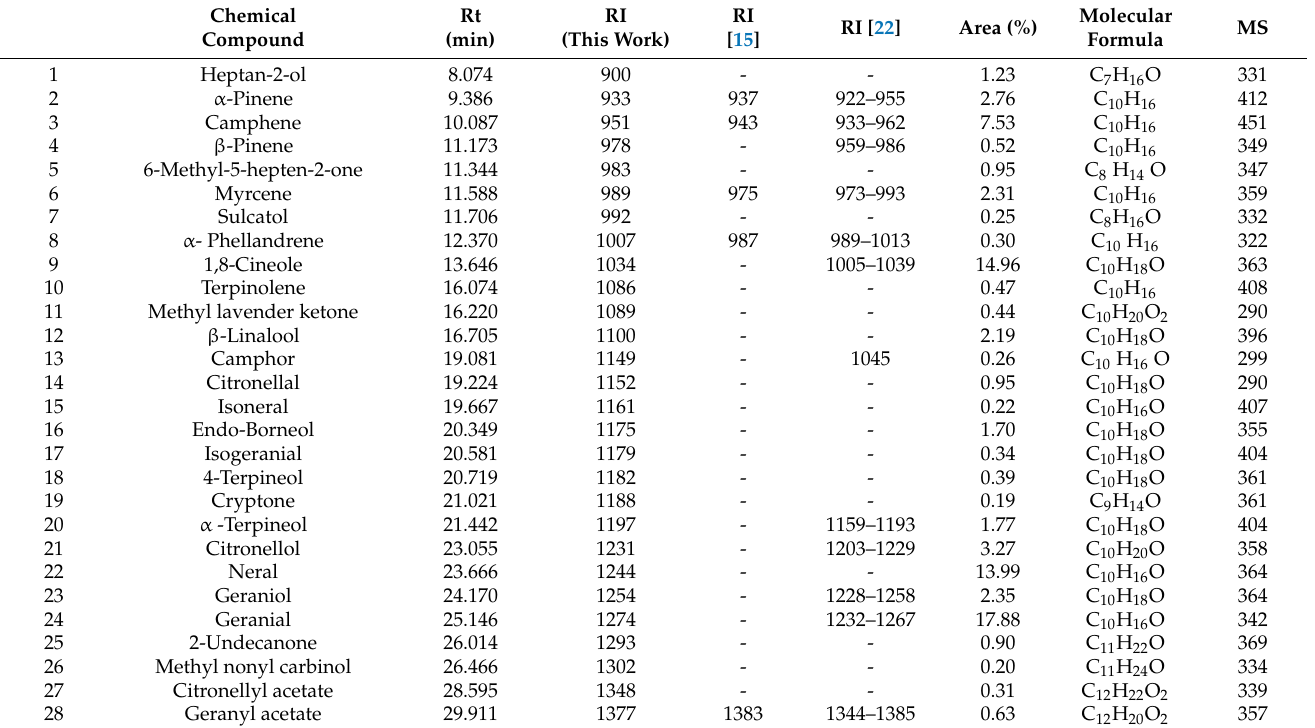
Table 1. Chemical compounds in GEO using GC–MS by matching their retention time (Rt), retention index (RI), molecular formula, and mass spectral (MS). Data from the mass spectral databases FFNSC1.3.lib, NIST11.lib, and WILEY229. Lib.